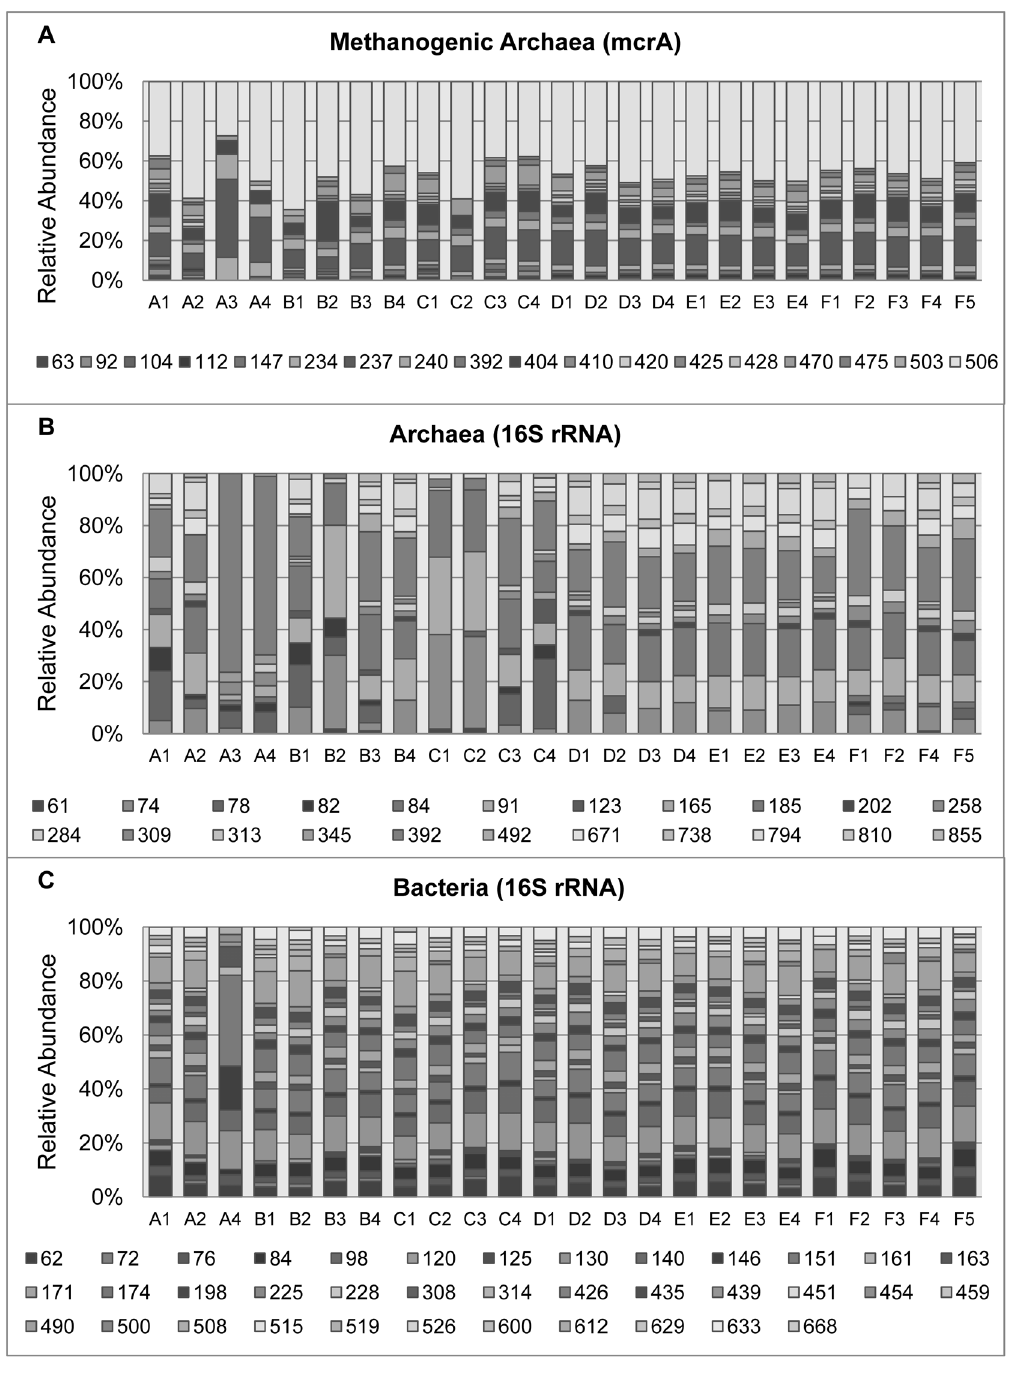
Figure 2. T-RFLP profiles of the three different genes studied in sediment inside the Lago Negro area. A1-F5 represent the sampling points (see Figure 1 for more details), the bar size represents the relative abundance of each OTU, which are defined by their size in base pair (bp). (A) mcrA , (B) Archaeal 16S rRNA gene, and (C) Bacterial 16S rRNA gene.